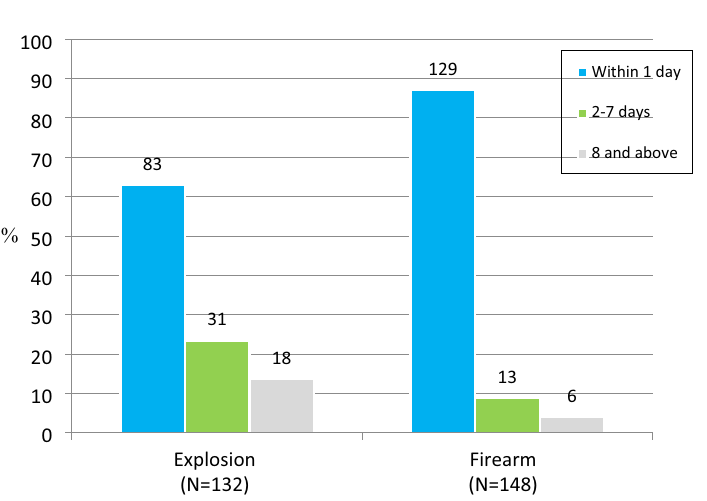
Figure 4. Time of Inpatient Death Due to Injury (Patients who died in hospital only) %, is the percentage in each cause